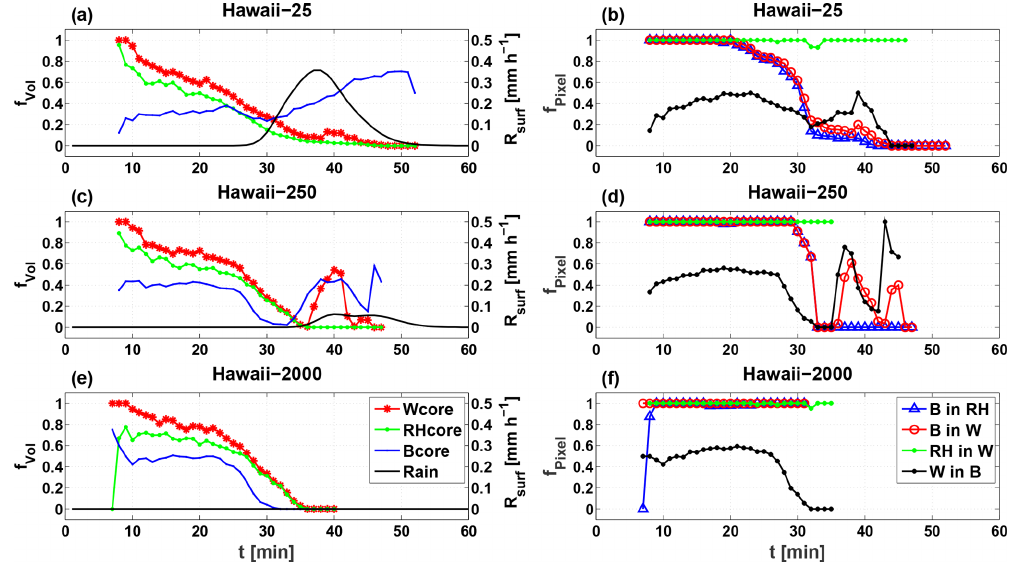
Figure 1. (a, c, e) Time series of core volume fractions ( f vol in %; left axis) and surface rain rate ( R surf in mmh − 1 ; right axis) for the clean (a) , intermediate (c) , and polluted (e) single cloud simulations. (b, d, f) Time series of pixel fractions ( f pixel in %) of one core type within another, for the respective simulation types. Core volume and pixel fractions are indicated by different line colors (see